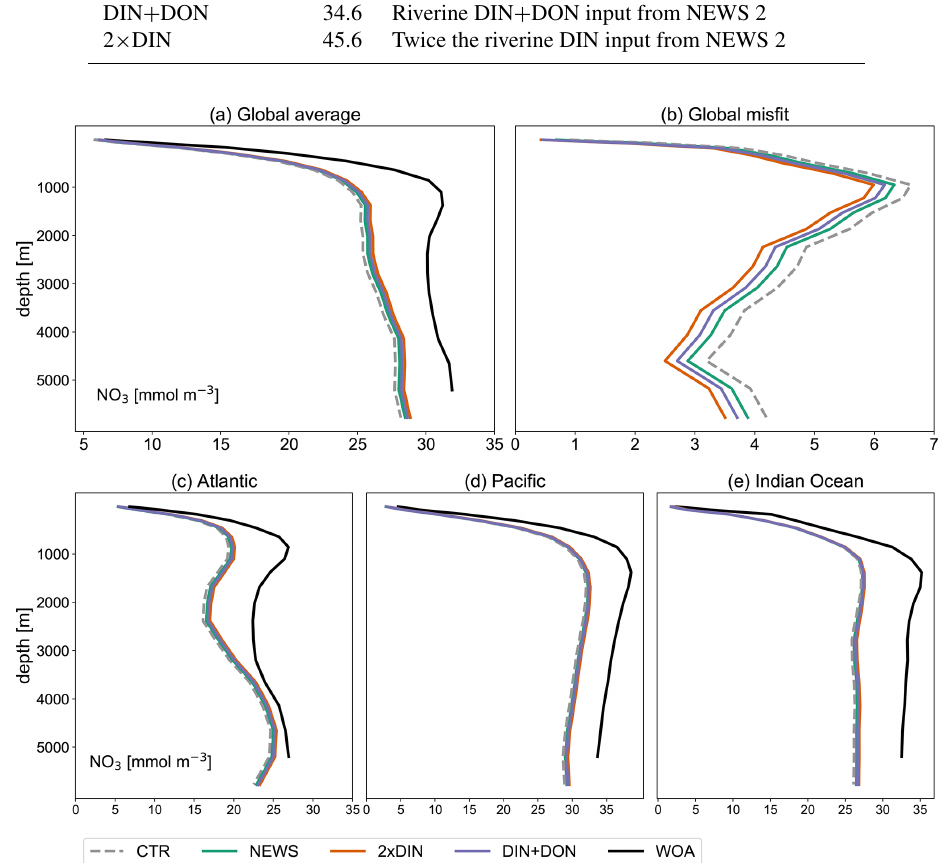
Figure 3. Profiles of global averaged NO 3 inmmolm − 3 from UVic simulations with and without riverine DIN export from NEWS data sets and observations with the WOA. (a) Global ocean average of NO 3 . (b) Global profiles of misfit in NO 3 compared to the observations. (c–e) NO 3 profiles for the three main ocean basins: the Atlantic Ocean (ATL), Pacific Ocean (PAC), and Indian Ocean